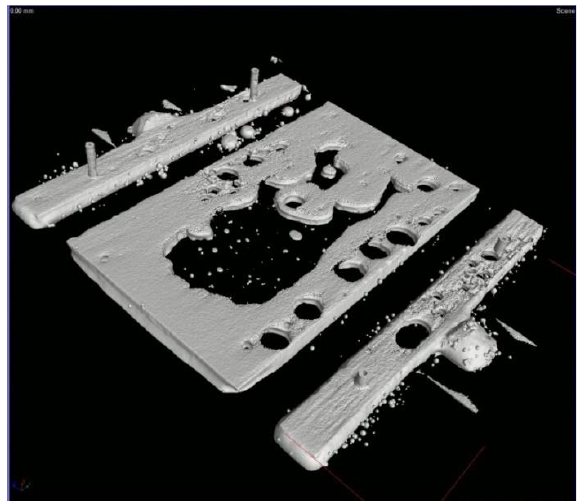
Figure 5. Three-dimensional (3D) CT image of a SACX0307-ZnO-(50 nm) solder joint.